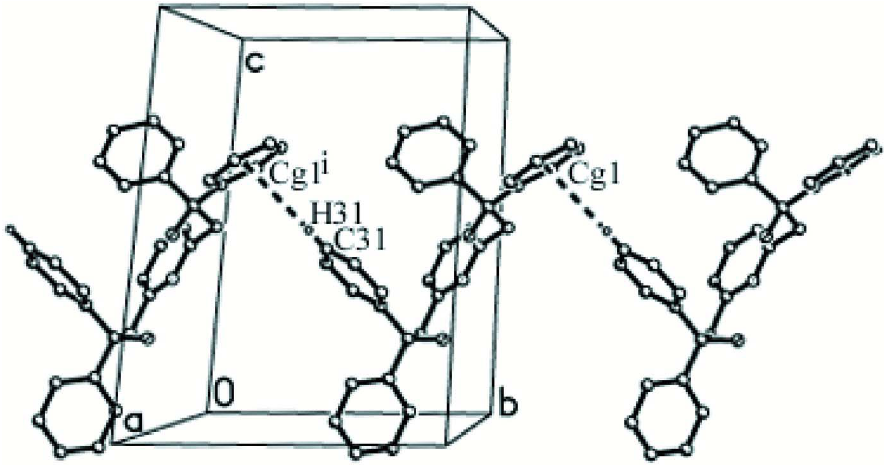
Figure 1 A view of the title compound showing the atom-numbering scheme and displacement ellipsoids drawn at 30% probability level. Dashed lines indicate hydrogen bonds and all H atoms except those involved in hydrogen bonding have been omitted for clarify.